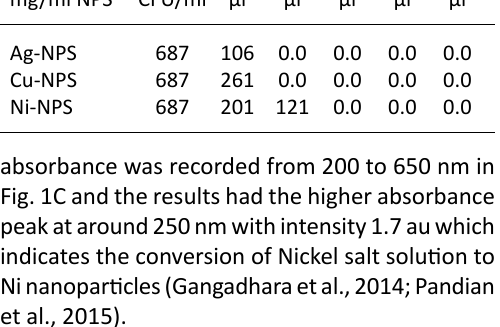
table 3. Effect of Ag-NPS, CU-NPS, Ni-NPS, synthesized by ginger on bacterial content of Mariout lake water sample Concen.300